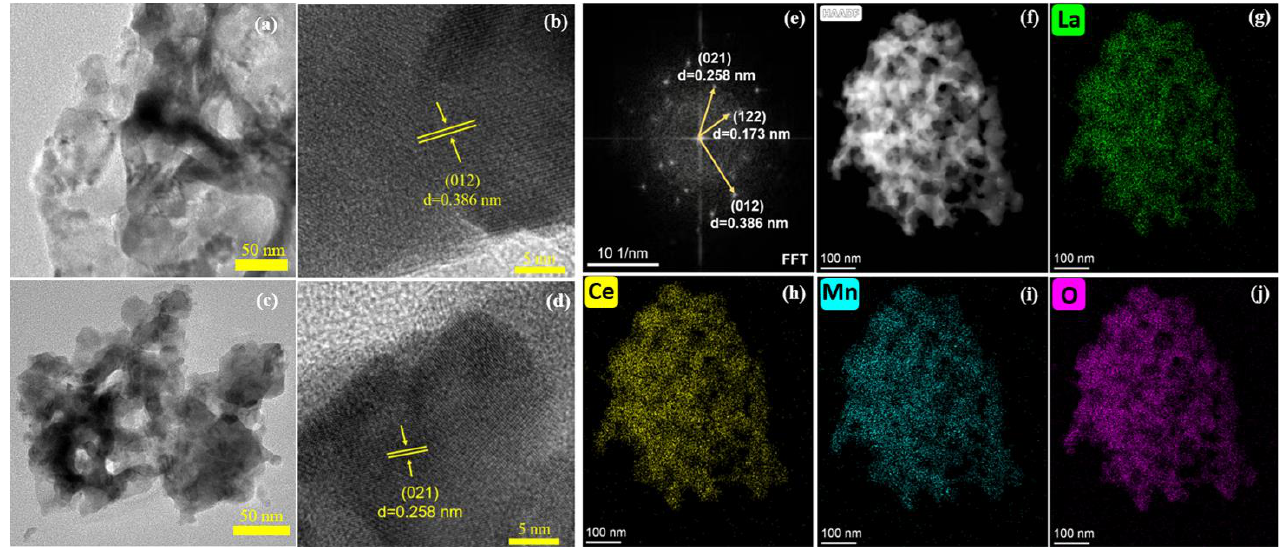
Figure 4. TEM images of ( a , b ) LaMnO 3 , ( c , d ) La 0.8 Ce 0.2 MnO 3 , ( e ) the corresponding SAED pattern and EDS images ( f – j ) of La 0.8 Ce 0.2 MnO 3 .